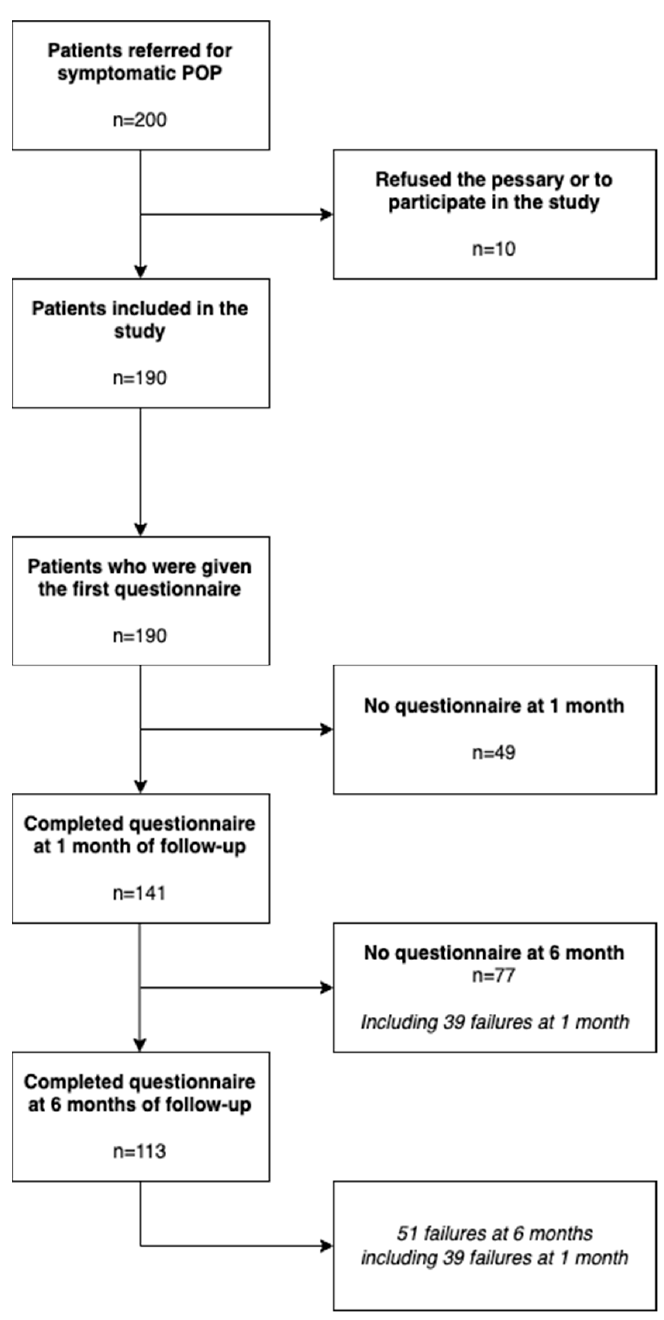
Figure 1. Flow chart of the patients recruited in our study (POP: Pelvic Organ Prolapse). The global symptom score PFDI-20 significantly improved after the pessary fitting, with a mean score of 105.22 at inclusion, 56.91 at 1 month, and 57.48 at 6 months ( p < 0.001 for global difference, p < 0.001 for M0–M1 difference, and p = 0.62 for M1–M6 difference). A significant improvement in the PFDI-20 score reaching the MCID or greater was observed for 73.5% and 72.8% of the women at 1 and 6 months. We found a significant improvement in the POPDI-6, UDI-6, and CRADI-8 subscores of the PFDI-20 with a similar profile. The USP subscore for overactive bladder (OAB) and low stream (LS) had also significantly improved ( p = 0.004 and p < 0.001, respectively). There was no improvement in the USP subscore for stress urinary incontinence (SUI). Neither were any improvements observed for the Wexner and Kess scores (Table